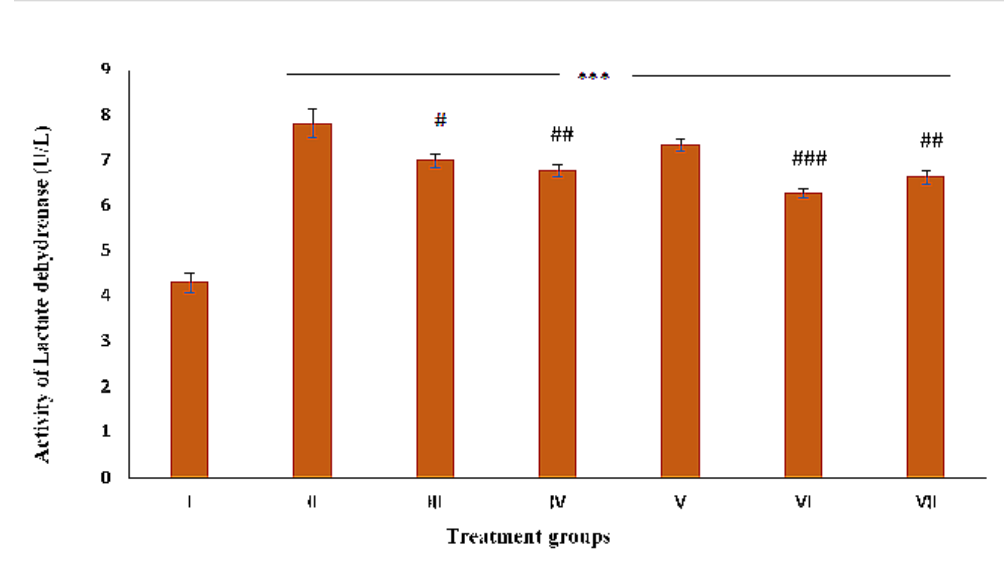
Figure 6. Bar diagram of the level of lactate dehydrogenase (LDH) in the liver samples. The activity of the enzyme is expressed in units/liter. The asterisk mark * indicates values significantly different from the control (group I), while # indicates values significantly different from the control positive (group II). All experiments were conducted in triplicate, and the data are presented as the mean ± SEM. p -values were calculated by Student’s t-test, ## p < 0.01; *** or ### p < 0.001.